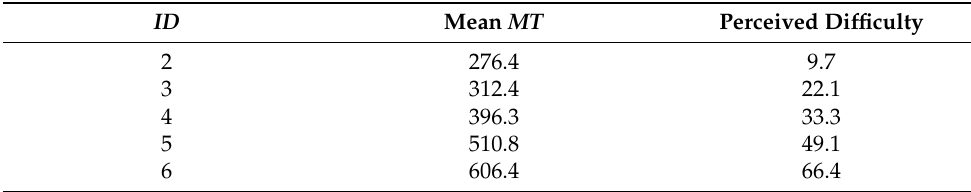
Table 14. Main effects of ID for mean MT and perceived